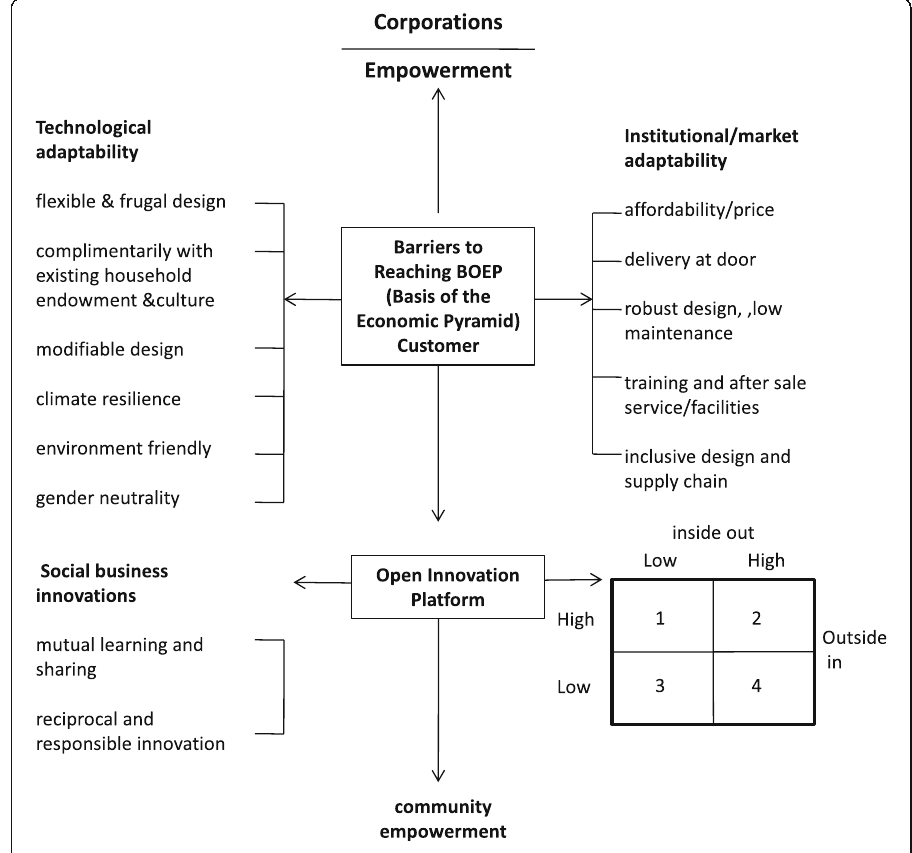
Fig. 3 Mutual empowerment of corporates and